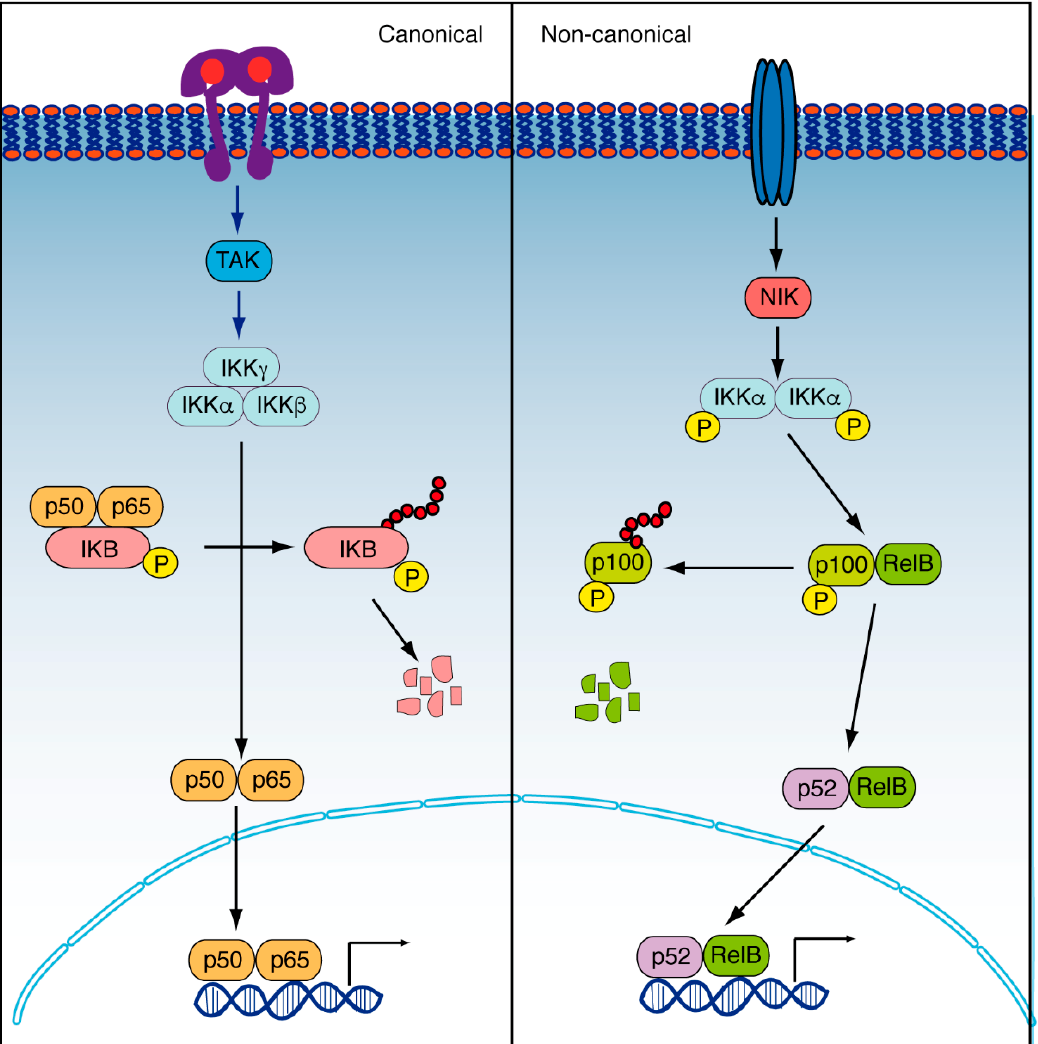
Figure 3. Canonical and non-canonical pathway of NF- κ B. On the ( left ), p50/p65 subunits are inhibited by I κ Bs; however, when the pathway is activated, I κ Bs are phosphorylated by the IKK complex integrated by IKK α , IKK β , and IKK γ and sent to degradation. Then, the p50/p65 are released and translocated in the nucleus to activate the transcription of the target genes. On the ( right ), in the non-canonical pathway, RelB is sequestered by p100. When the pathway is activated, IKK α phosphorylates and sends p100 to degradation. Then, RelB is released and forms a dimer with p52, which is translocated to the nucleus. Abbreviations: I κ B kinase complex (IKK); Transforming growth factor- β –activated kinase 1 (TAK); NF- κ B-Inducing Kinase (NIK).